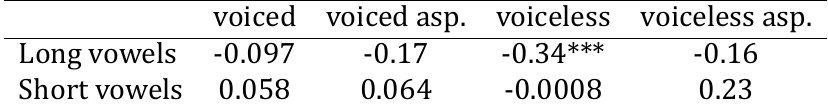
Table 7: Correlations between Hindi vowel duration and total stop duration (closure + aspiration). N was approximately 61 in each